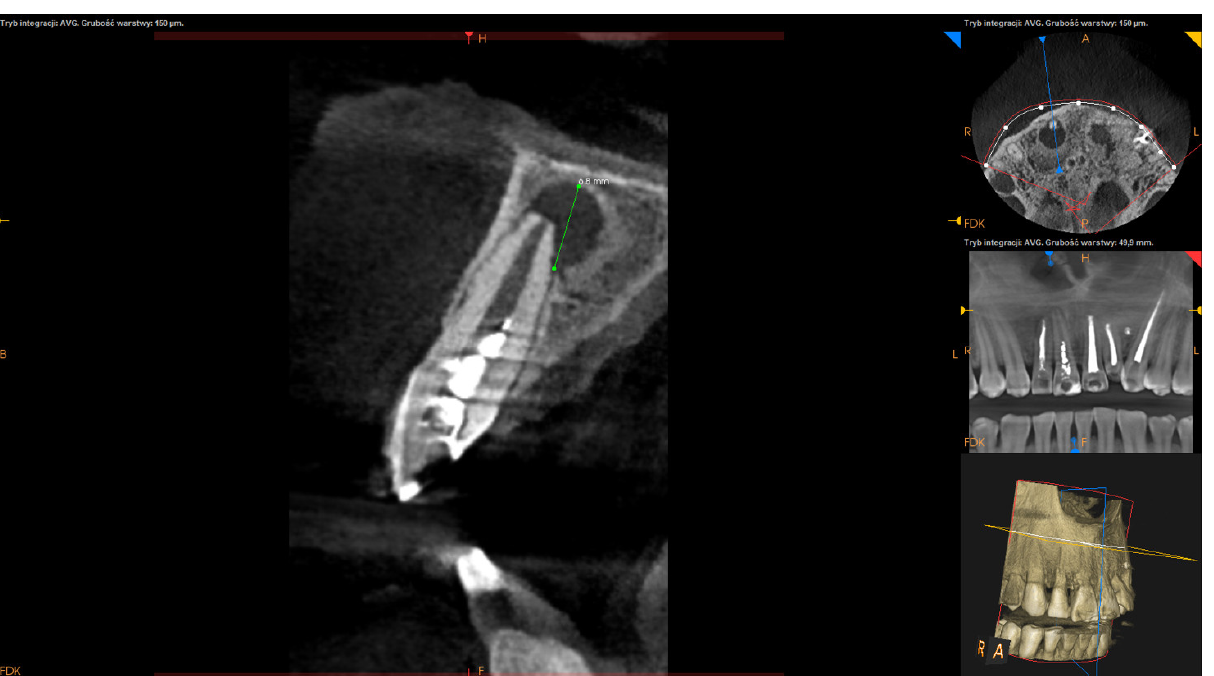
(Mectron); ( c ) filling the root-end cavity with the use of MAP system ® (Produits Dentaires SA); ( d ) filling of the defect with bone substitute graft; ( e ) resorbable membrane covering the graft.